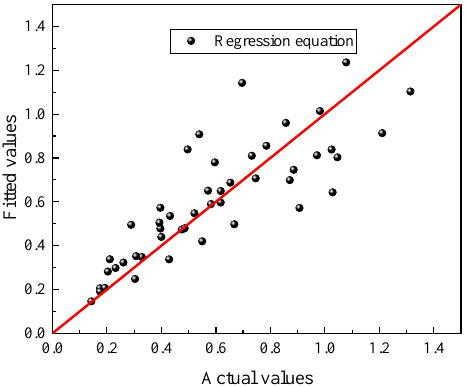
Figure 5. The comparison of actual values and fitted values for v/k.